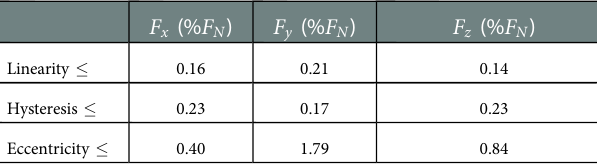
TABLE 3 Linearity, hysteresis, and eccentricity errors with nominal force F N ranging between 0 and 1600 N. Error bounds expressed as a percent of F N .